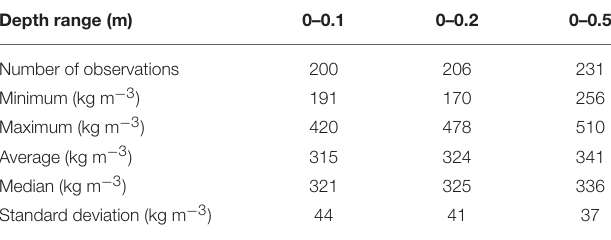
TABLE 2 | Surface snow density dataset metadata for three depth ranges.